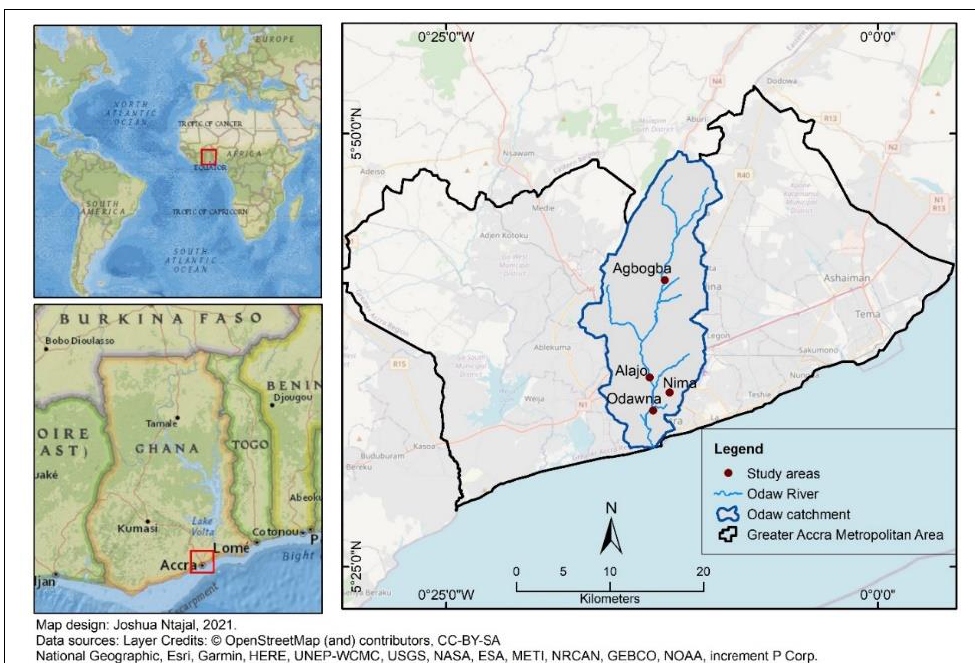
Figure 1. Map of the study sites in the Odaw River basin.